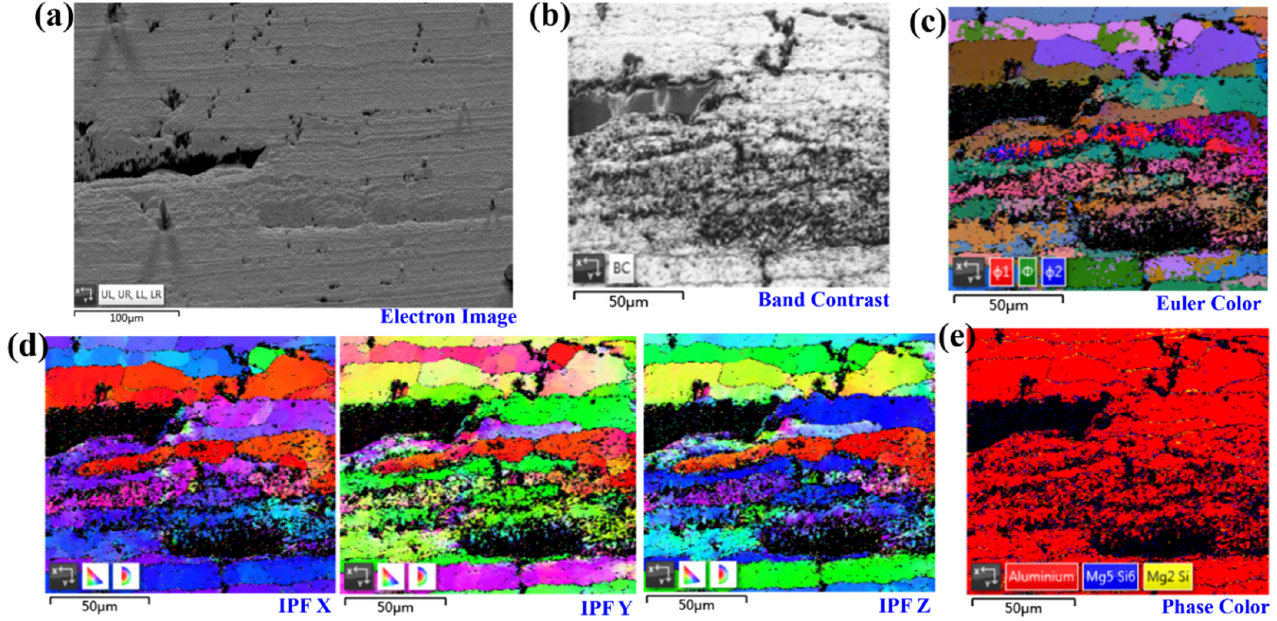
Figure 8. EBSD characterizations of the pitting and IGSCC features in the 0.75B plane: ( a ) the electron image of the crack tips together with precipitates and pits; ( b – e ) the characterizations of selected regions in terms of band contrast, Euler color, the inverse pole figure (IPF) of the x ‐ , y ‐ , and z ‐ axes, and the phase map, respectively.